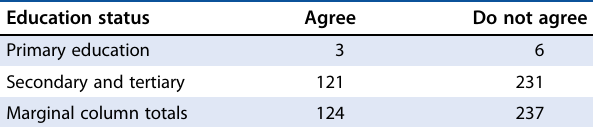
Table 5: Educational status vs. adequate training and development opportunities to improve skills Education status